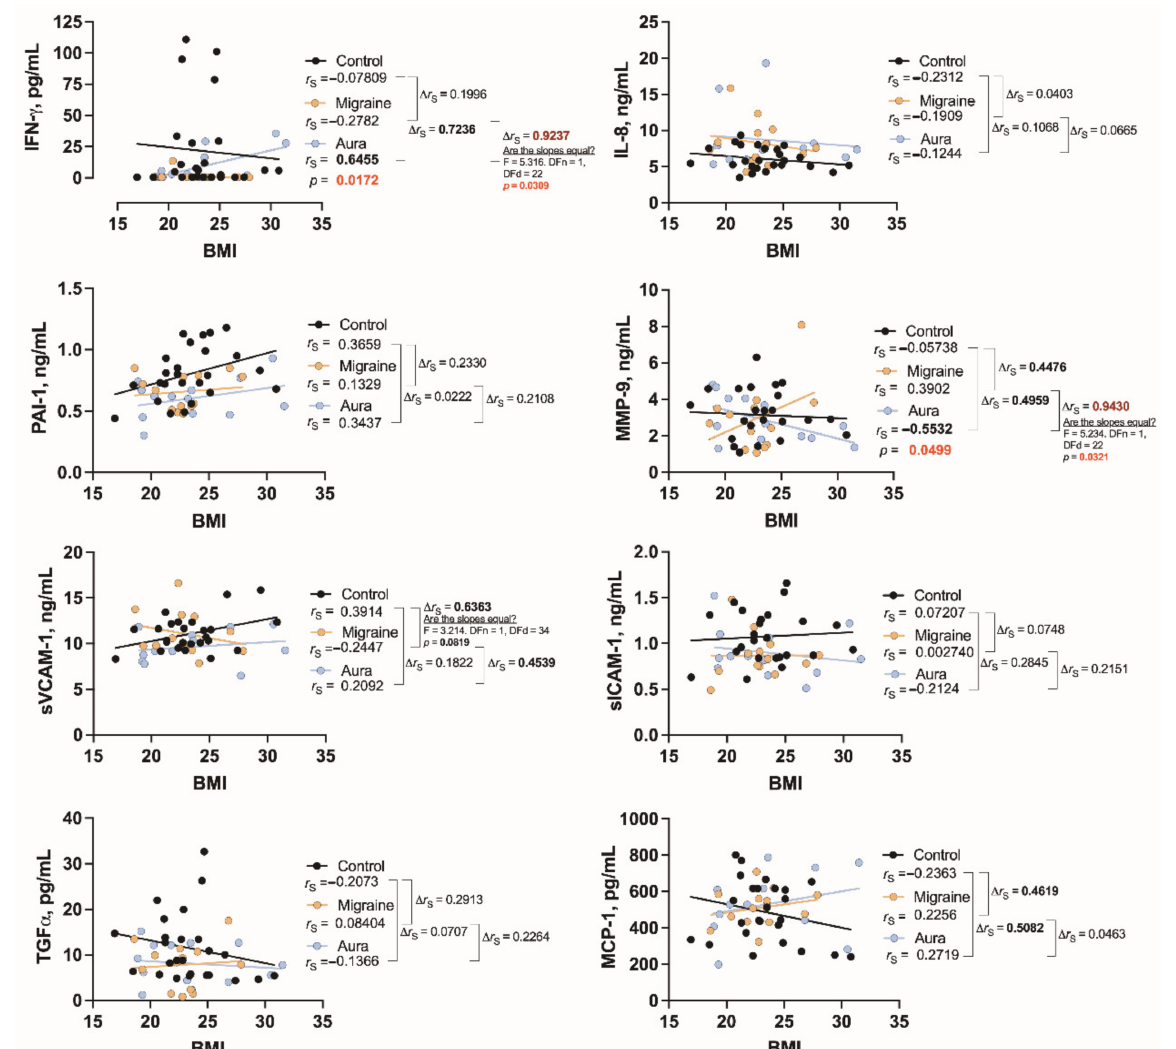
Figure 3. The relationship between BMI and cytokines studied in healthy individuals (control) and in patients with migraine without aura (migraine) and with aura (aura). r S : Spearman’s rank correlation coefficient, ∆ r S : the difference between the correlation coefficients as an indicator of the magnitude of the differences (more significant differences are marked in